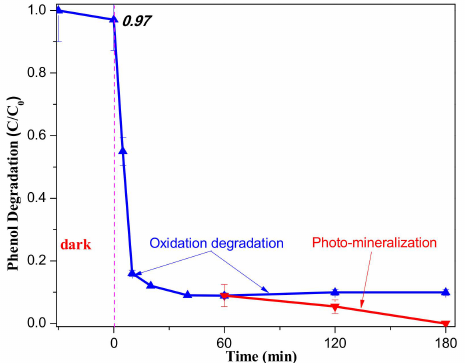
Figure 7. Phenol removal under chemical oxidation–degradation and photo-mineralization.